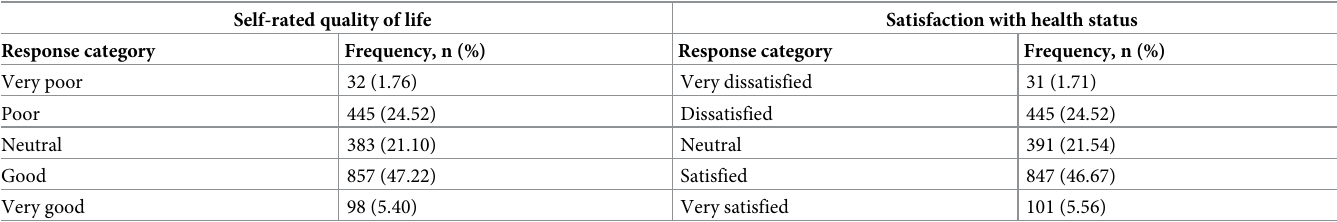
Table 2. Self-rated quality of life and health status satisfaction among chronic disease patients in Amhara region, Ethiopia (n = 1, 815). Self-rated quality of life Satisfaction with health status Response